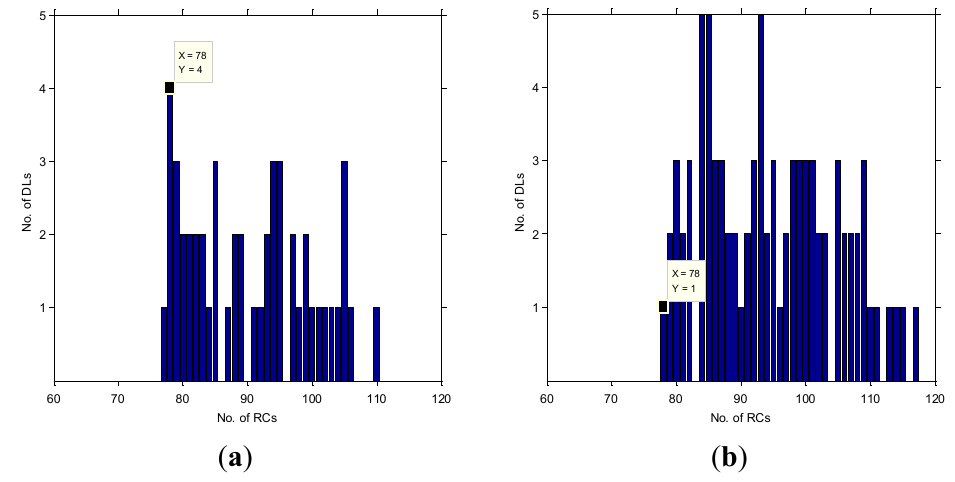
Figure 5. Bar plots of the number of detected RCs from the first measurement of the first subject case from ( a ) respiration signal in positive amplitudes for all DL and ( b ) respiration signal in negative amplitudes for all